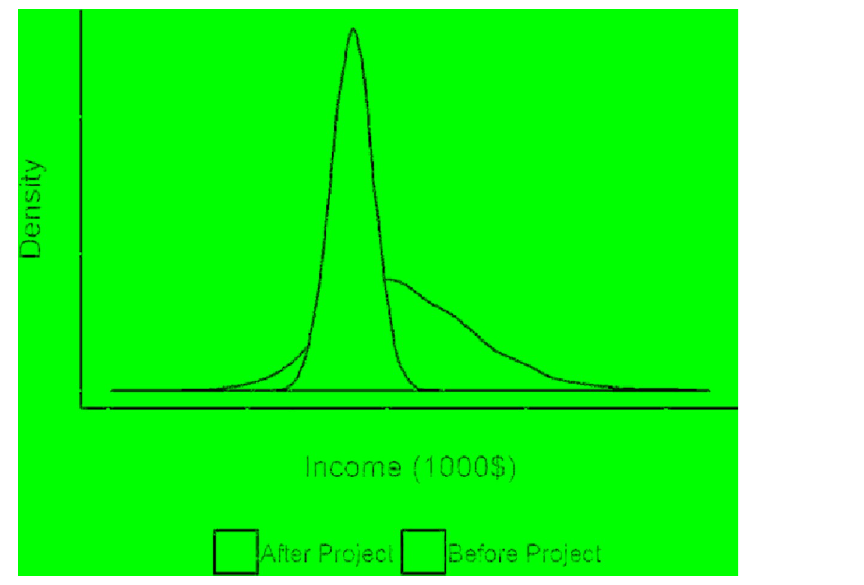
Fig 5. Yearly income distribution before and after adopting